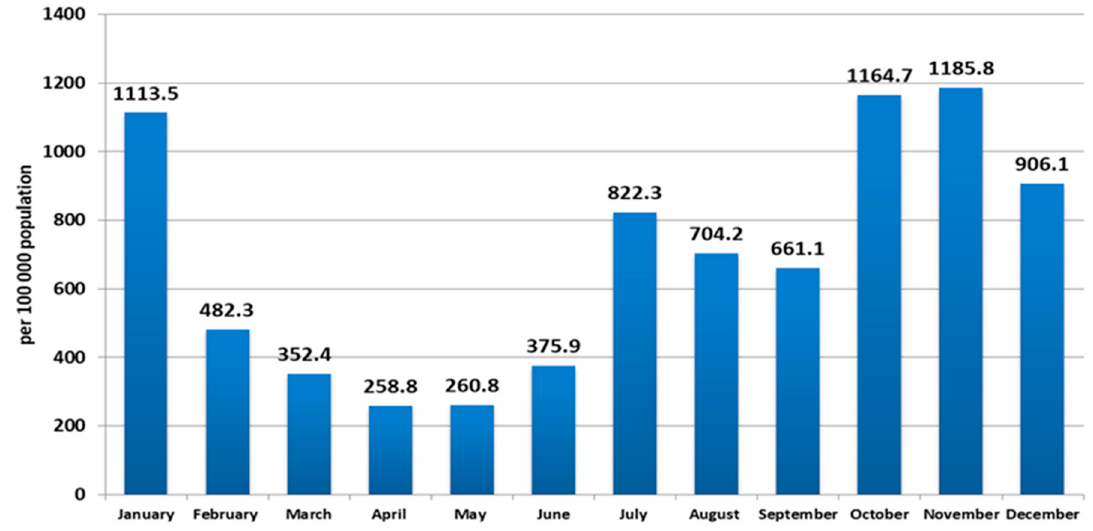
Figure 1. COVID-19 incidence in northwest Russia in 2021. Periodic increases and decreases in incidence can be noted. Figure based on Rospotrebnadzor data.